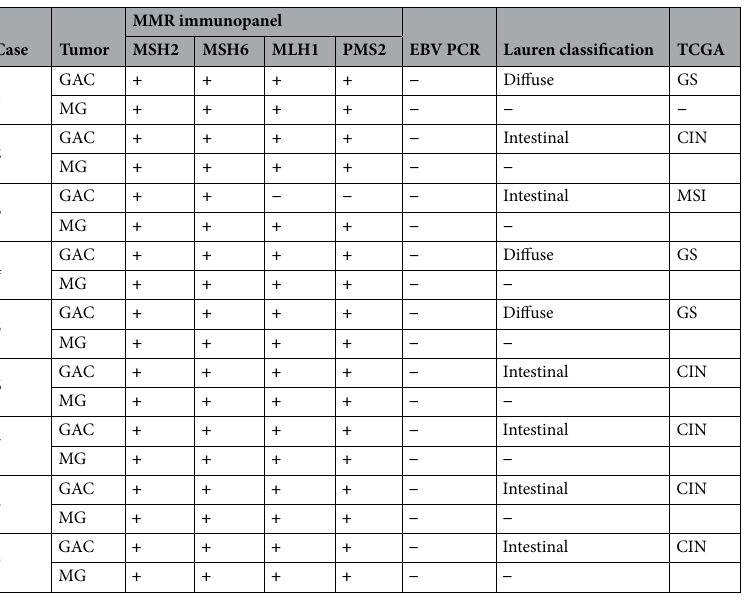
Table 3. EBV and MRI status of the tumors and approximated TCGA subtypes. GAC gastric adenocarcinoma, MG microscopic gastrointestinal stromal tumor (micro-GIST), MMR mismatch repair, EBV Epstein–Barr virus, PCR polymerase chain reaction, TCGA The Cancer Genome Atlas Project, GS Genomically Stable, CIN chromosomal